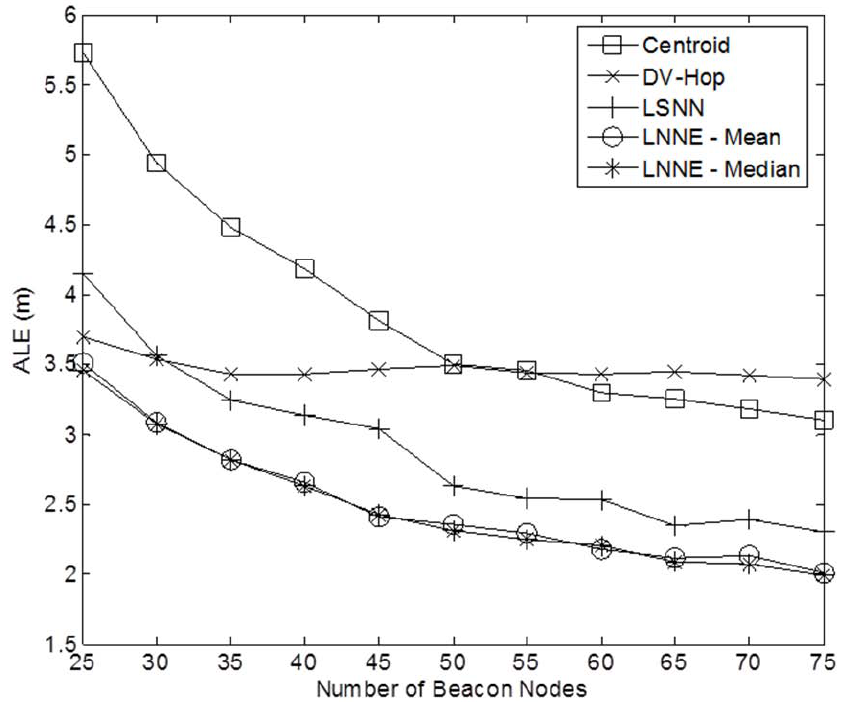
Figure 9. Performance comparison under different beacon ratios (0.1–0.3) and 1 coverage hole.